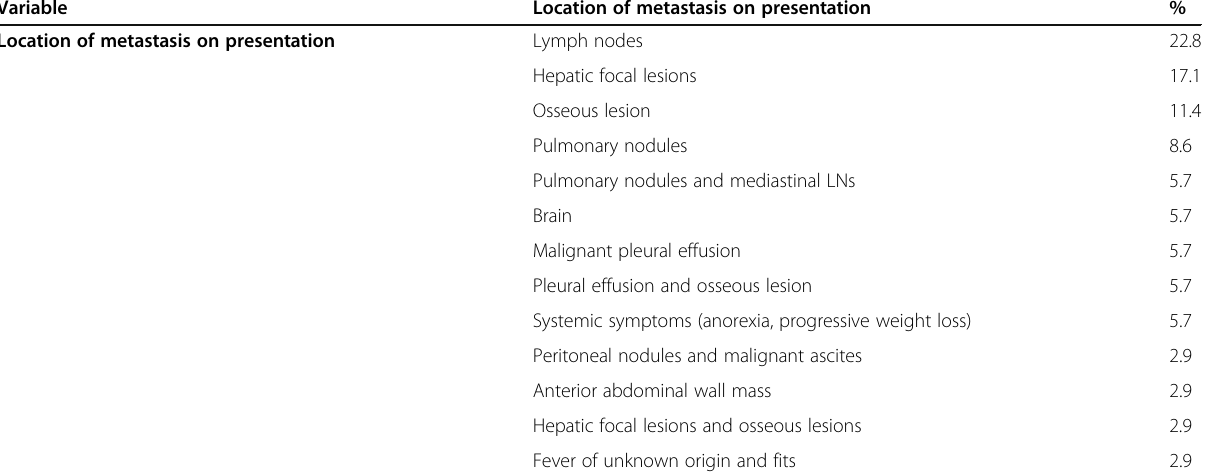
Table 1 The location of metastasis on presentation Variable Location of metastasis on presentation Location of metastasis on presentation